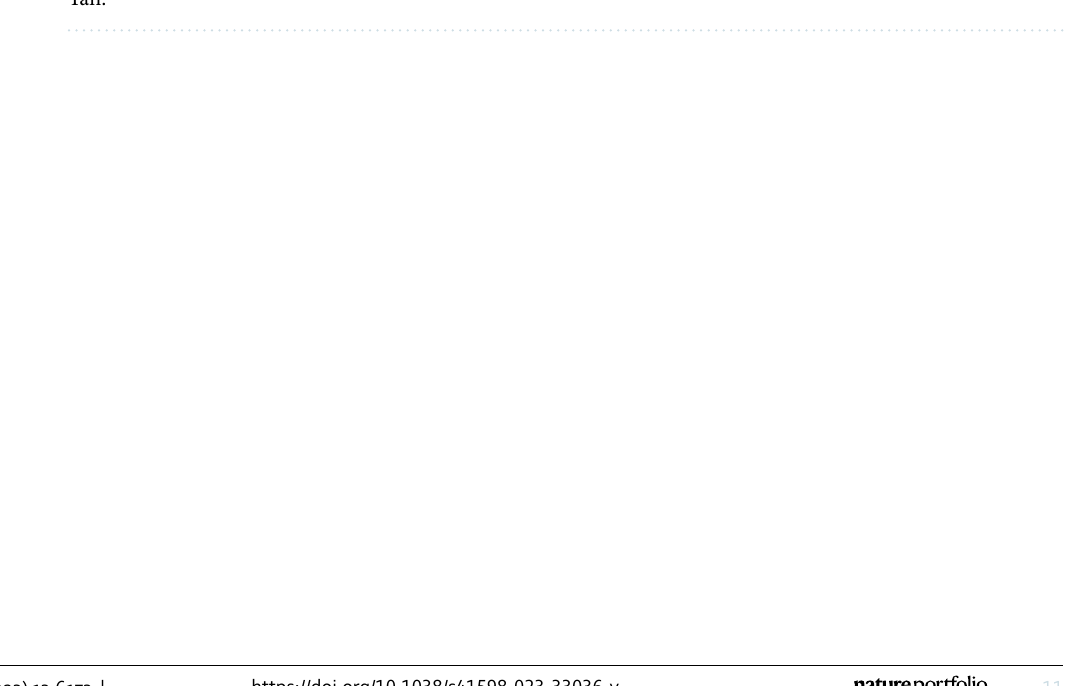
Table 5. Fitting results and main parameters of the models of Thomas, Clark,Yoon-Nelson, Bohart Adam and